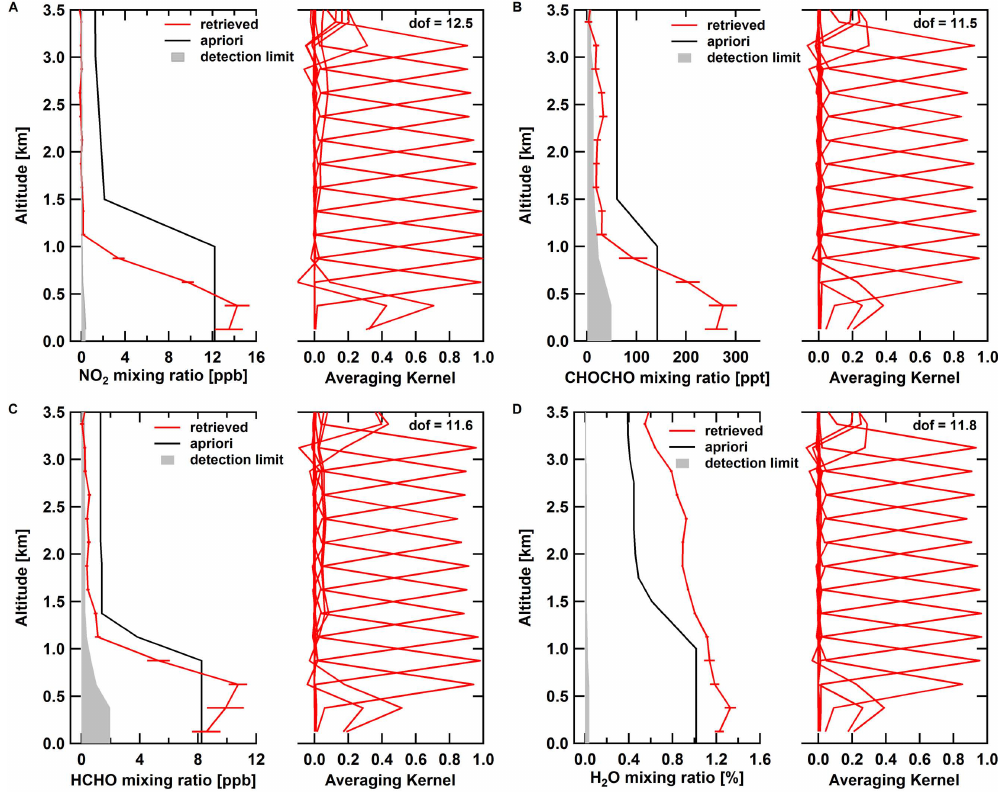
Fig. 11. Retrieved vertical profiles and corresponding averaging kernels for (A) NO 2 , (B) CHOCHO, (C) HCHO and (D) H 2 O from the low approach at Brackett airfield. NO 2 , CHOCHO and HCHO profiles show most of the trace gases are located close to the source region inside the BL. Averaging kernels indicate almost constant sensitivity for all trace gases over the entire altitude range. Grey shaded area represents detection limit for each